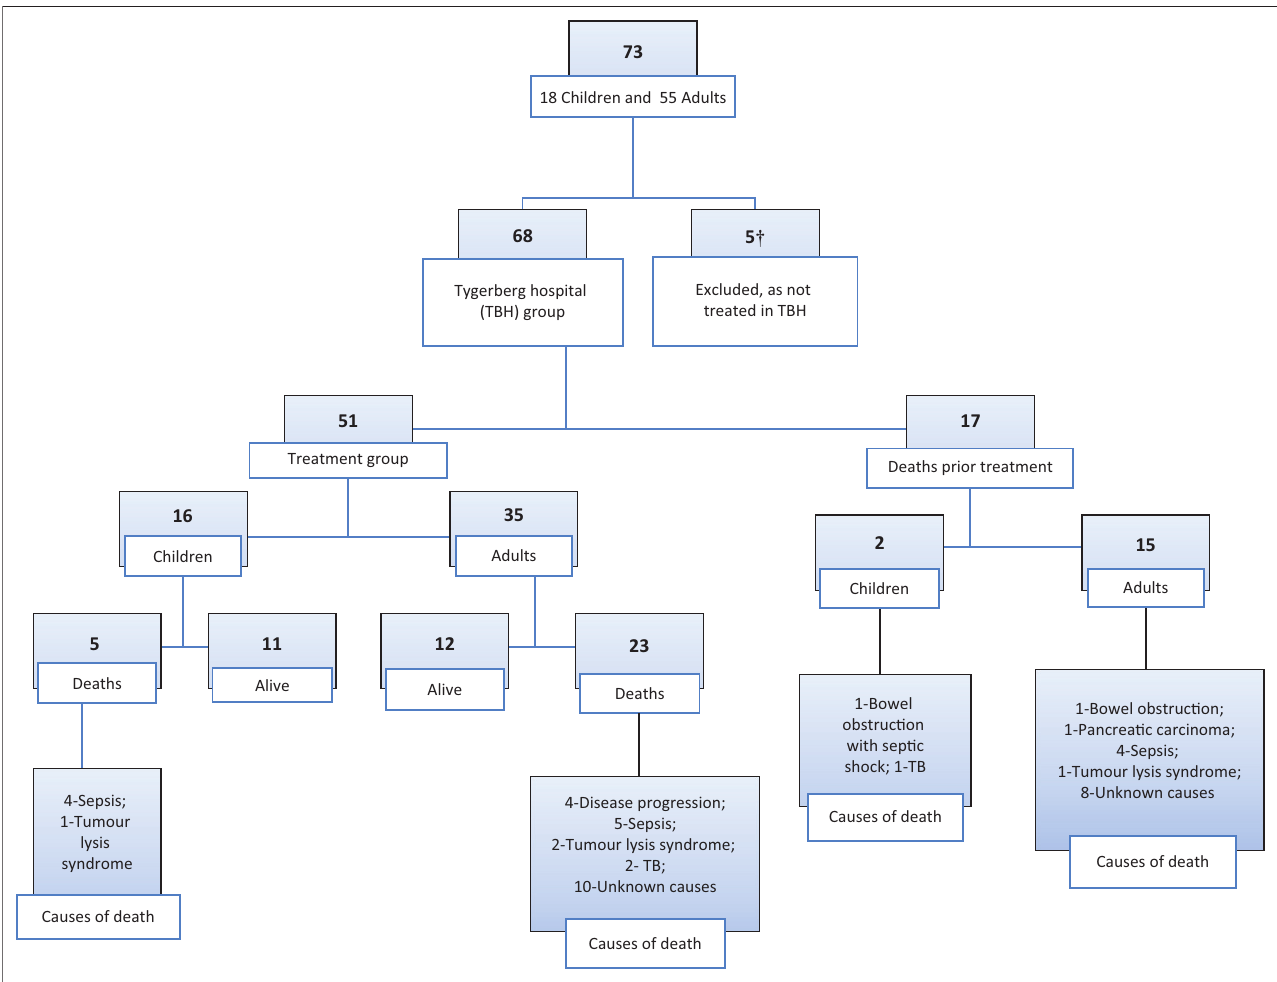
FIGURE 1: Schematic outline of Burkitt lymphoma